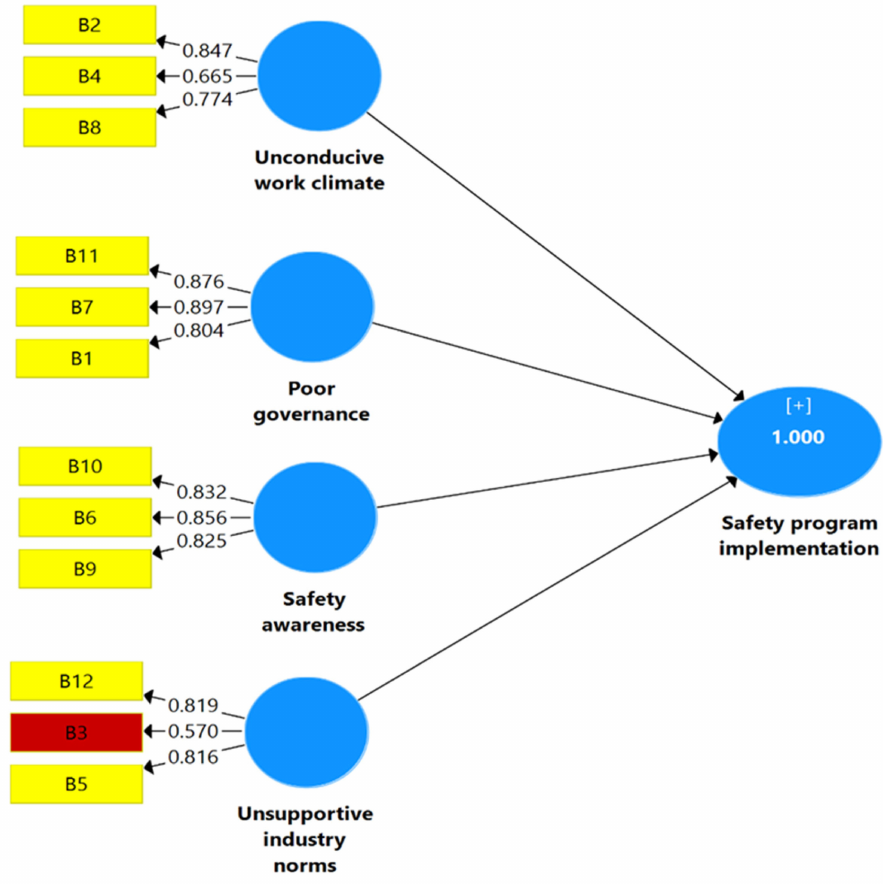
Figure 3. Structural model. Table 3. Construct reliability and validity